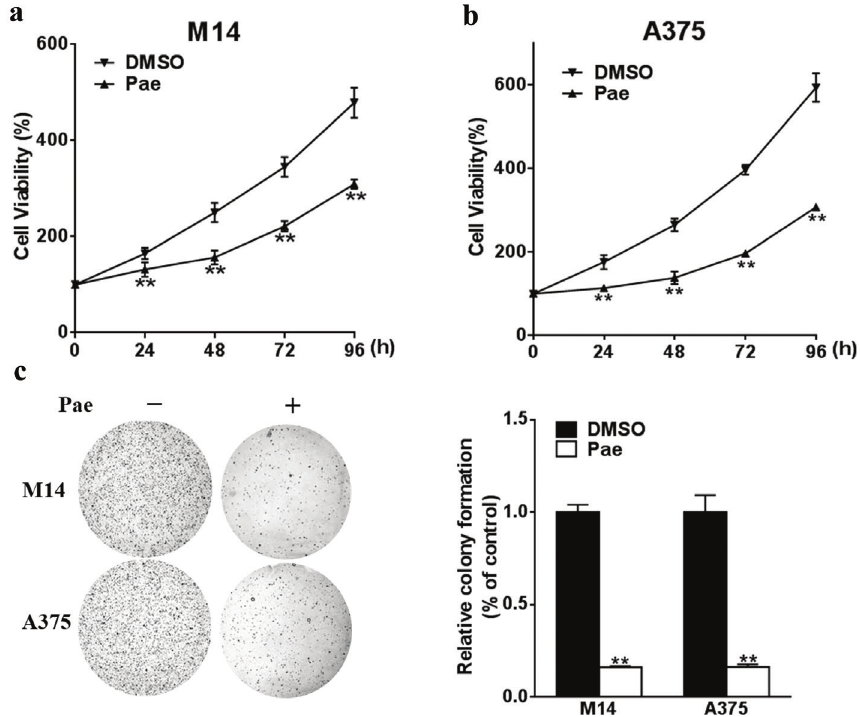
Fig. 1 . Paeonol (Pae) inhibits cell proliferation and growth of melanoma. M14 and A375 melanoma cells were treated with 500 μM Pae or DMSO. (a, b) CCK-8 assay was used to test cell proliferation. (c) Colony formation assay was employed to analyze the cell growth ability. ** P < 0.01 versus